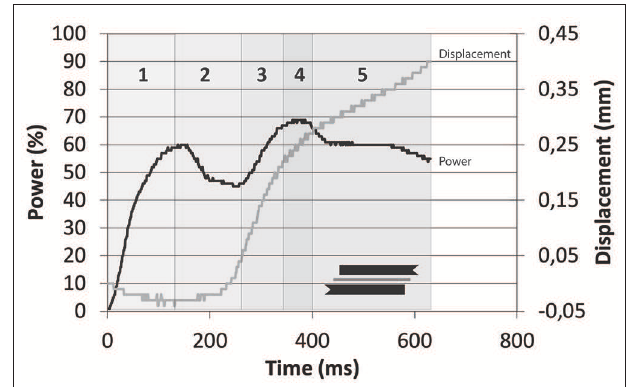
FIGURE 5 | Power and displacement curves for ultrasonic welding of CF/PPS single-lap coupons with flat energy director (energy director thickness = 0.4mm, welding force = 500N, vibration amplitude 86 µ m peak-to-peak). Definition of stages 1–5 in the welding process. Data obtained following the methodology described in Villegas et al. (2015).